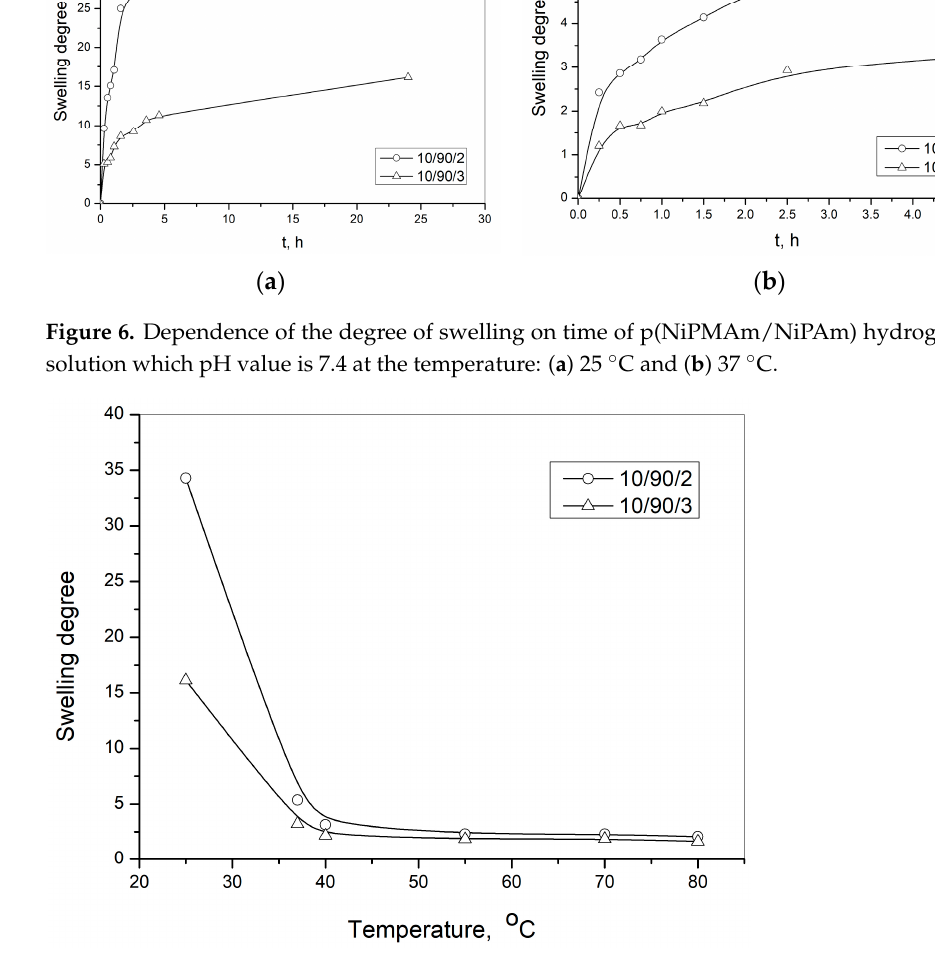
Figure 7. Dependence of the degree of swelling on temperature in the solution in which pH value is 7.4.